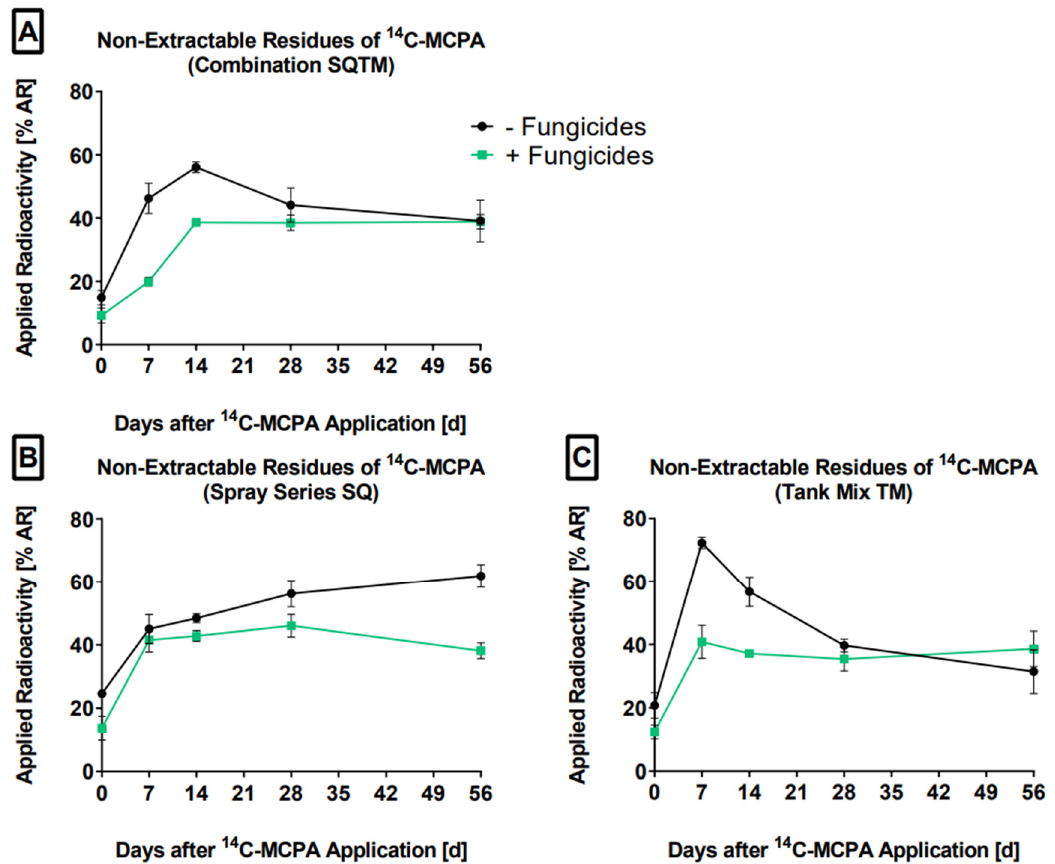
Figure 3. The non-extractable residues (% AR) of MCPA in the absence (-F, black line) and presence (+F, green line) of the fungicides on days 0, 7, 14, 28, and 56 are presented. ( A ) SQTM-F: control, SQTM +F: combination ( B ) SQ-F: control, SQ+F: spray series, and ( C ) TM-F: control, TM+F: tank mix. The mean values and standard deviations were derived from triplicates (n = 3).